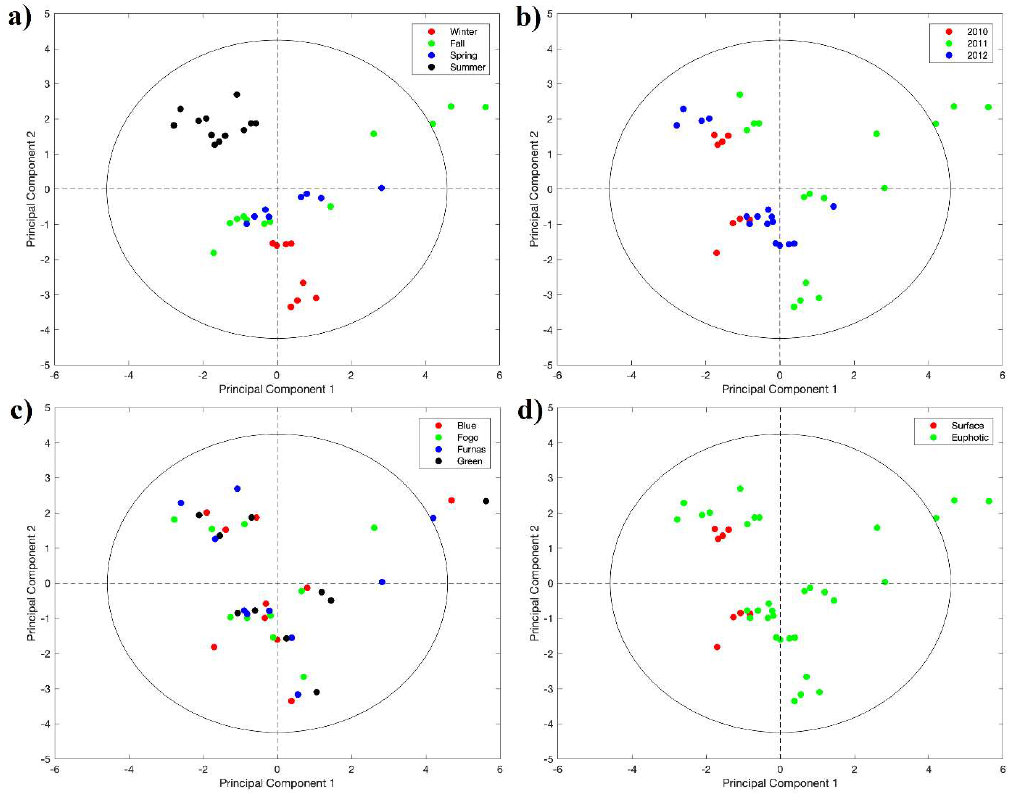
Figure 13. A multivariate analysis of the conjugation of set data A and set data E, colored according to season ( a ), year of the collection ( b ), lakes ( c ), and depth of collection ( d ).